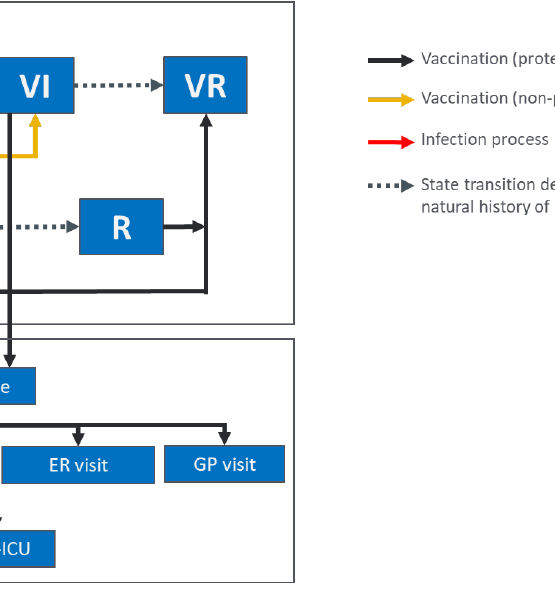
Figure 1. Outline of the epidemiological and economic model structures. S, E, I, and R represent susceptible, exposed, infectious, and recovered individuals, respectively, for the individual influenza strains. VS, VE, and VI represent susceptible, exposed and infectious individuals who received an influenza vaccine which was non-protective for the strain in question; VR represents individuals who were vaccinated and protected against influenza (either through infection following non-protective vaccination or through vaccination). In the economic model, infected individuals are categorized based on their healthcare usage. ER, emergency room; GP, general practitioner; ICU, intensive care unit. Data on circulating influenza strains from 2012 to 2019 were obtained from Flunet, using specific data for Canada [23]. As no specific incidence rate data were available for Canada, these values were used to generate calibrated attack rates specific to strains based on disease-burden data from the US from 2012 to 2019 (Supplementary Table S2) [25]. Each year was categorized as being a matched or unmatched year for each individual vaccine strain [26] (see Table 1). VE measures per strain for those years were obtained from the SPSN network [27]. Relative VE (rVE) of QIVc vs. QIVe was estimated using data pooled from retrospective studies for the 2017–2019 influenza seasons [16,17,28–30]. The rVE per strain was calculated assuming only that the A/H3N2 strain was unmatched during egg-adapted years in using the method described in the US study [20]. rVE was assumed to be constant across age groups, with an extra assumption that available data for estimating rVE (based on individuals ≥ 4 years of age) was also applicable to children <4 years of age. The economic model was based on that described in Fisman et al. [31], using the same input parameters as presented in Table 2. Similar to the Fisman model, the age-specific impact of influenza was assessed as estimated probability of healthcare utilization visits multiplied by the number of resource units and the unit-cost of each visit. The number of cases estimated from the epidemiological model were used as an input for the economic model to estimate the other outcomes, such as hospitalization and death. Vaccine price parameters were estimated using the product list price [32], with an assumption that 50% of children <3 years of age would require two doses. Although Canada does not have a formal incremental cost-effectiveness ratio (ICER) threshold, we assumed that an ICER < CAD 50,000 per quality-adjusted life year (QALY) would be cost-effective. The